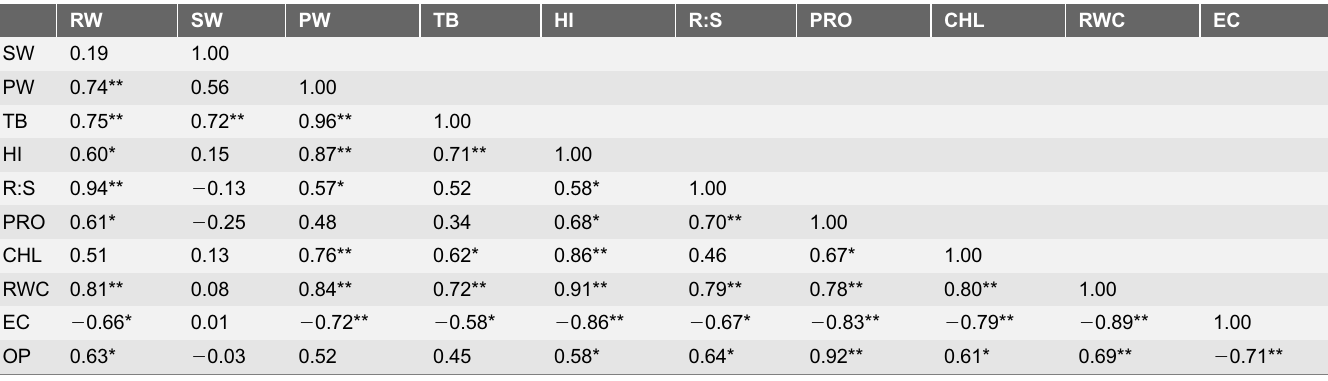
For each parameter, average values of three AtDREB1A transgenic peanut lines along with WT were used (Refer to Table